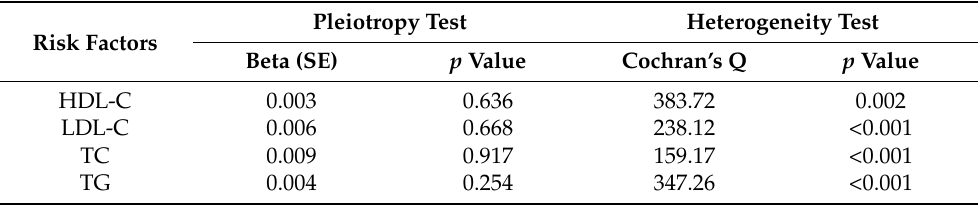
Table 2. Tests of pleiotropy of selected SNPs and heterogeneity between SNPs. Pleiotropy Test Heterogeneity Risk Factors